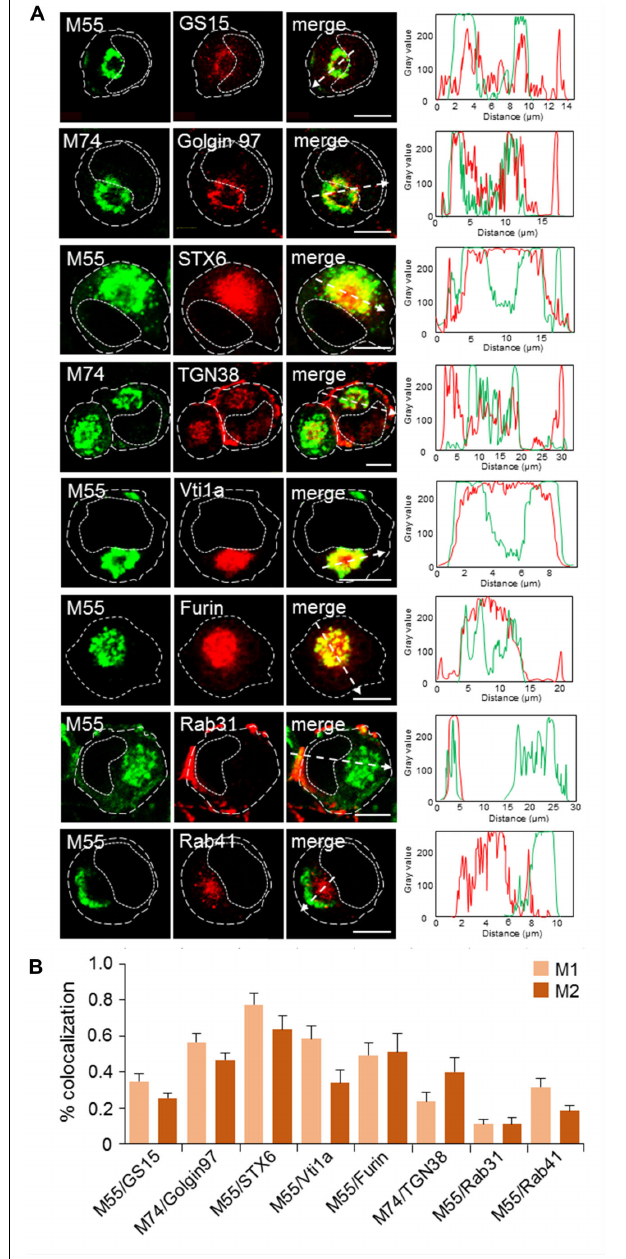
FIGURE 5 | Subcellular distribution patterns of Golgi markers at 48 hpi with MCMV. (A) Immunofluorescence analysis. Golgi-derived membranes were visualized using Ab reagents to cellular proteins that characterize various stages of Golgi maturation ( Supplementary Table S2 ), and viral envelope glycoproteins were visualized using mAb reagents to M55 and M74. Antibody reagents used are listed in Supplementary Table S1 . Colocalization analysis was performed by plotting fluorescence intensity profiles along white dashed lines and shown in the right column. Cell borders are indicated by fine dashed lines and nuclei by fine dotted lines. Bars, 10 µ m. (B) Colocalization analysis of M55/M74 and classical steady-state organelle markers based on M1/M2 coefficients of pixel overlap measured across the Costes-algorythm thresholded z-stacks of confocal images. Data represent mean ± SEM per cell ( n = 6–10). 1-column fitting